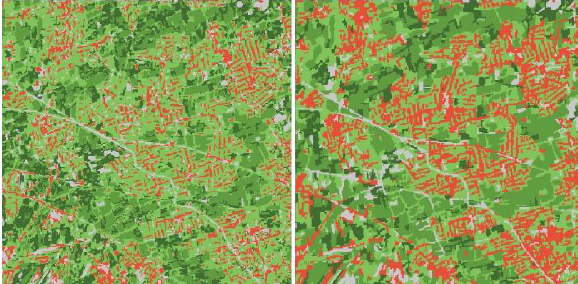
Figure 7. Results from the Random Forest classification of the Ehlers fusion image (left) and the original Landsat image (right). Class colours: light green (garden plots), green (summer crop fields), dark green (orchards), red (urban), grey